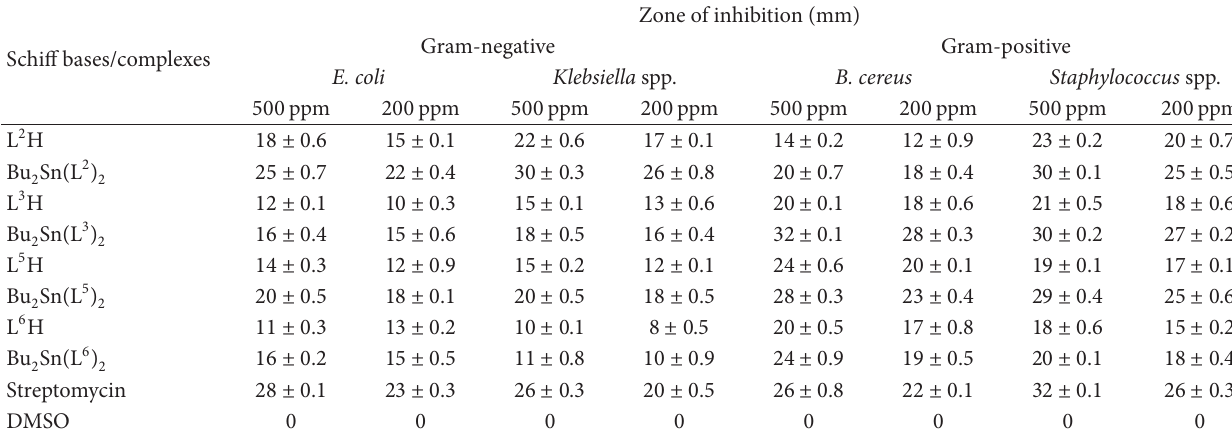
Table 8: Antibacterial activity of ligands and their organotin(IV) complexes.